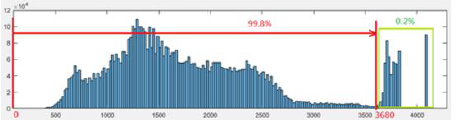
Figure 4. Example of removing the top 0.2% of signals from the histogram.